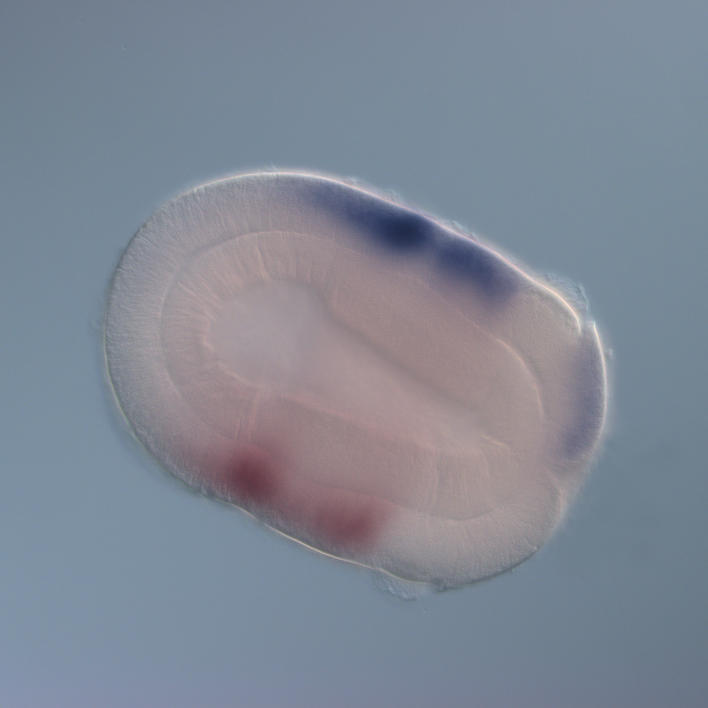
The embryo of the hemichordate Saccoglossus kowalevskii expresses the chordin gene on the ventral midline and the bmp2/4 gene on the dorsal midline. All dorsoventral development depends on this Bmp–Chordin polarity.